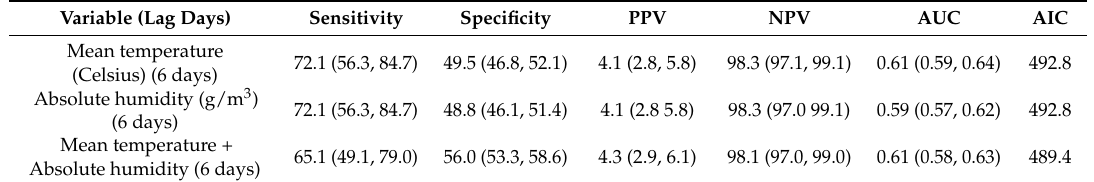
Table 2. Estimated diagnostic performance of climatological prediction models for forecasting the incidence of Bacillus spp. blood culture.